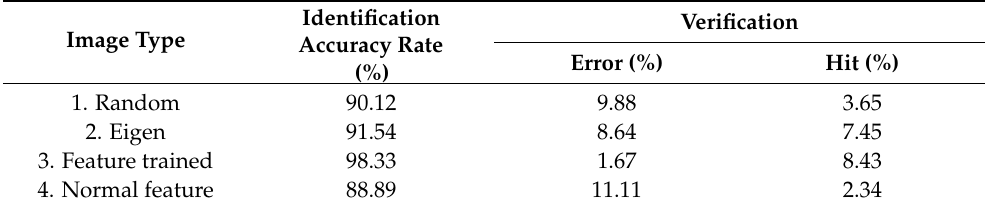
Table 1. Database (own